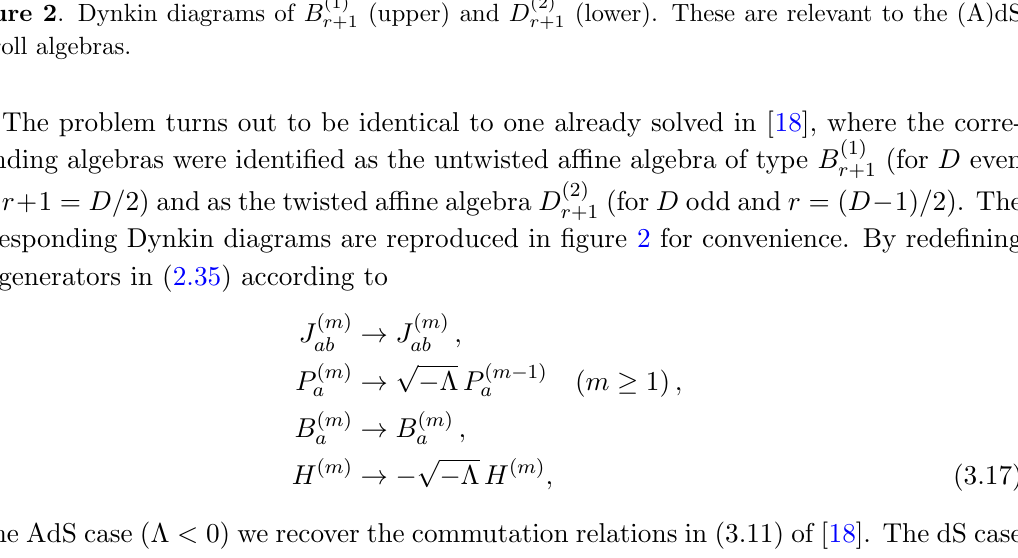
(upper) and D (2) (lower). These are relevant to the (A)dS r +1 r +1